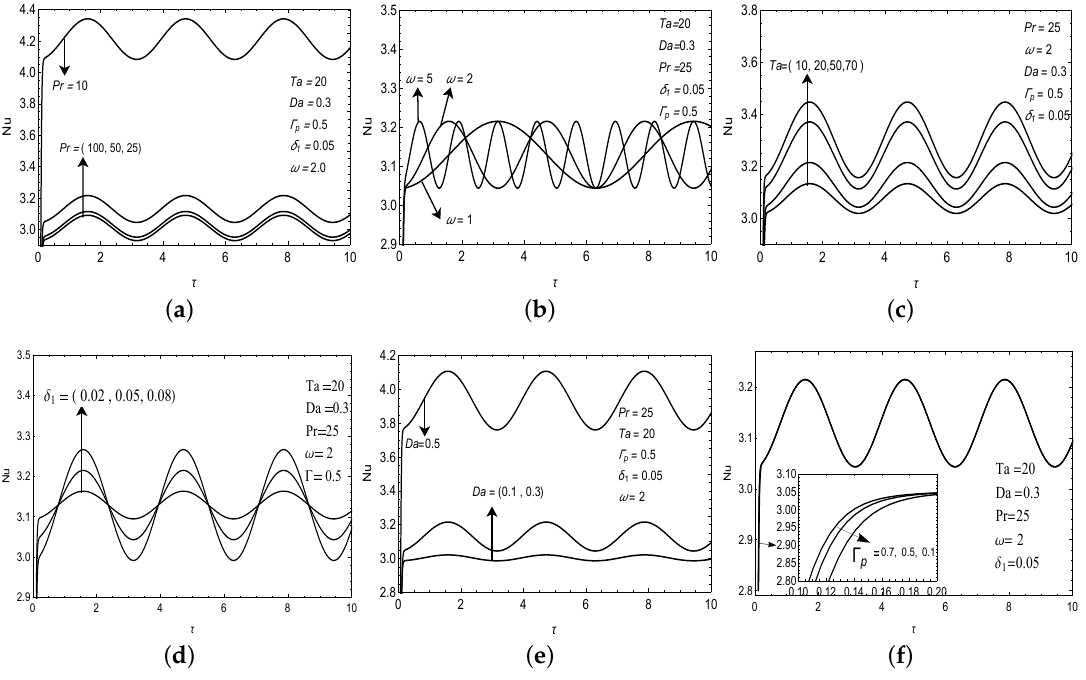
Figure 2. Variation of Nusselt number ( Nu ) with slow time ( τ ) for different values of parameters ( a ) Pr , ( b ) ω , ( c ) Ta , ( d ) δ 1 , ( e ) Da , ( f ) Γ p